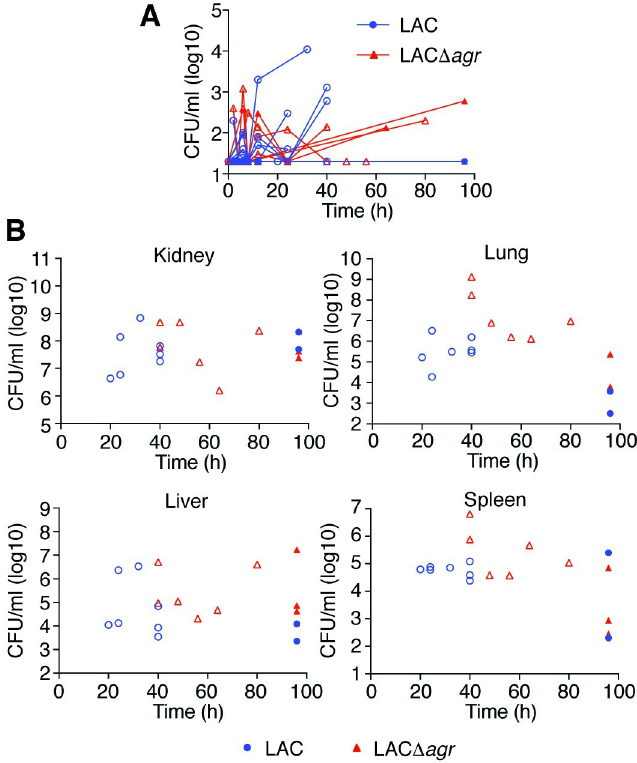
Fig 3. Rabbit non-catheter-associated sepsis model–CFU in blood and organs. ( A ) Bacterial CFU in the blood over time. ( B ) Bacterial CFU at the time of death or the end of the experiment in the indicated organs. Empty symbols represent animals that died during the observation